Question: In a single sentence, describe what this figure presents.
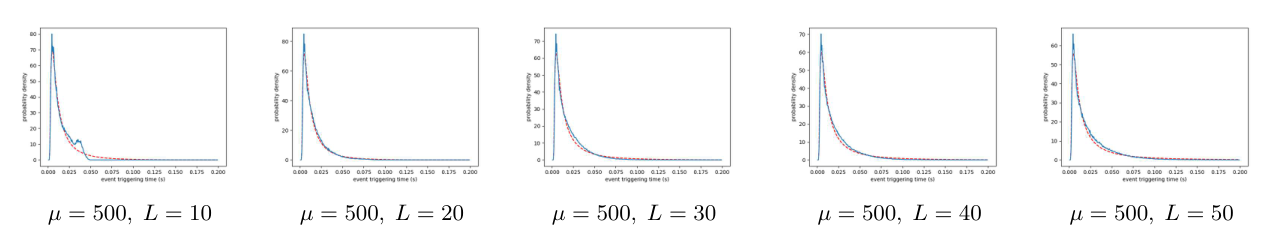
Answer: shows the statistical distributions of event triggering time as the histograms with blue lines in different conditions. The ﬁtting curves above the histograms, marked as red dashed lines, roughly follow the inverse Gaussian distribution. As is exempliﬁed in Fig. 4, there exists signiﬁcant discontinuity in the histograms, which is also shown in Fig. 3. It validates the existence of the time delay ∆te between consecutive trigger- ing events caused by charge and discharge of parasitic capac- itor of photodiode PD. In Fig. 3, the lengths of discontinuity remain the same in each row but vary in each column, which demonstrates that the time delay ∆te only depends on µ rather than current light intensity L. Therefore, the time delay ∆te follows a non-ﬁrst- order behavior. We also evaluate the discontinuity length quantitatively in Table 2. The time delay ∆te declines with the increasing of changing speed µ, which can also be seen in Fig. 3. Fur- thermore, the product of ∆te and µ is al